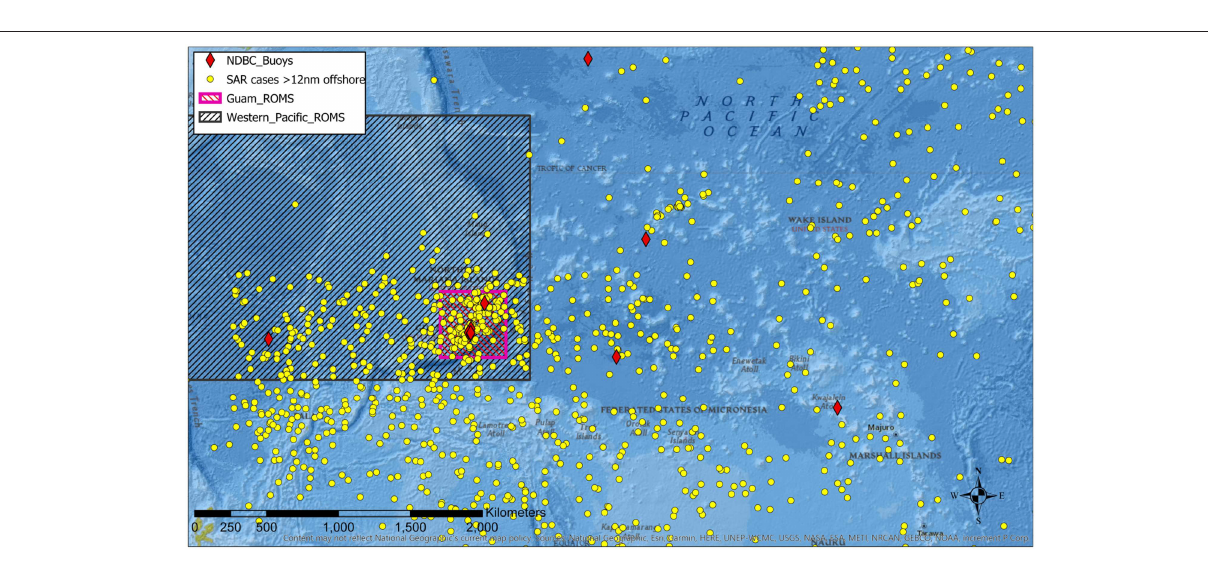
Frontiers in Marine Science |